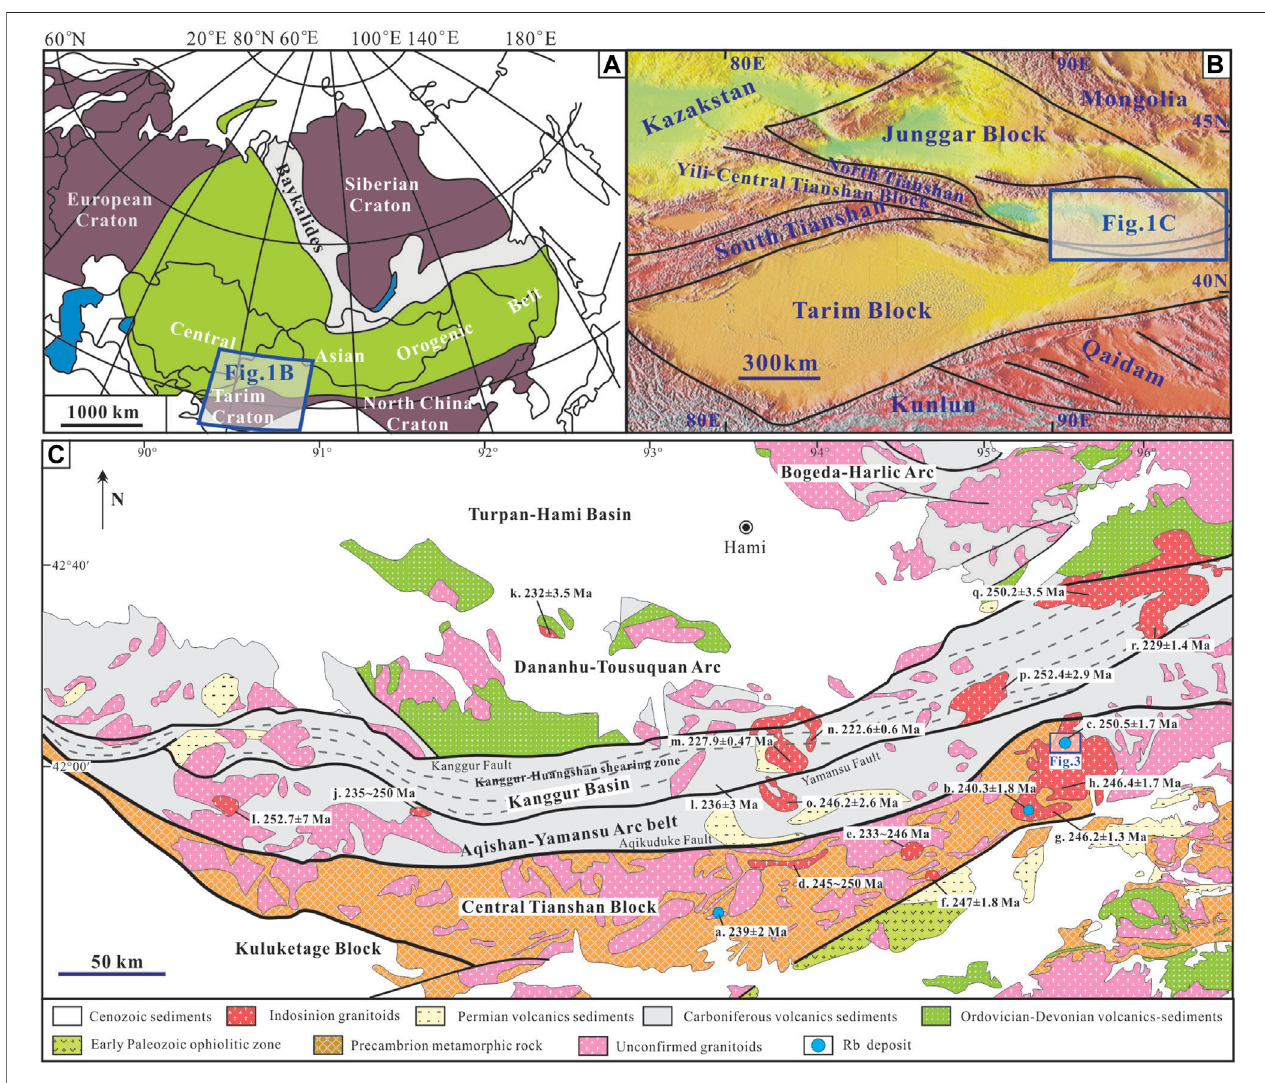
FIGURE 1 | (A) Tectonic sketch map of the Central Asian Orogenic Belt (modi fi ed from Sengor et al., 1993). (B) Topographic and tectonic sketch map of Xinjiang, Northwest China, andadjacentareas (modi fi ed fromMuhtaret al.,2020a). (C) Geologicalmap oftheEasternTianshan(modi fi edfrom Wanget al.(2006) andDeng etal. (2017)). (a – r represents dated Triassic granitoids and related metal deposits, please see name and reference information in Supplementary Appendix Table 1